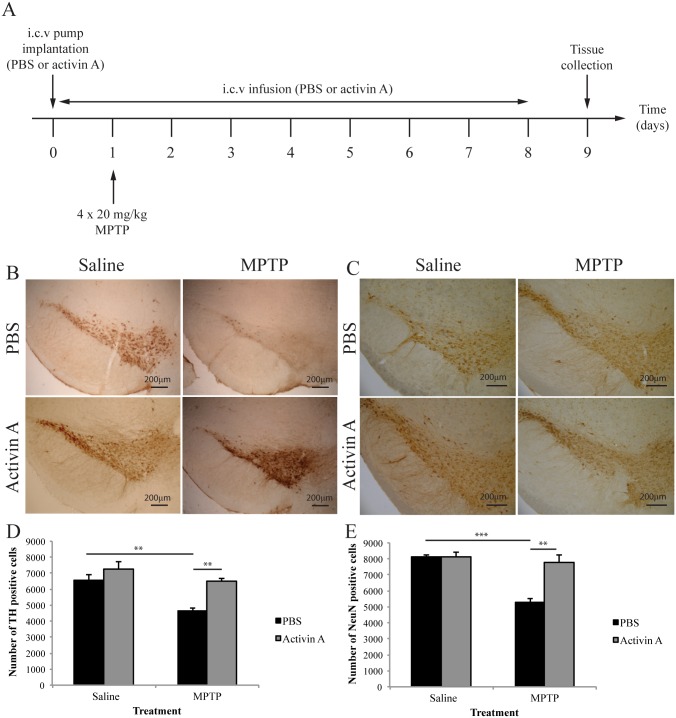
Activin A protects nigral neurons against MPTP-induced cell death.(A) Experimental timeline. (B) Representative images of TH-immunoreactive neurons in the substantia nigra pars compacta (SNpc). (C) Representative images of NeuN-immunoreactive neurons in the SNpc. (D) Stereological quantification of TH-immunoreactive neurons in SNpc demonstrates activin A protects dopaminergic neurons against MPTP toxicity. (E) Stereological quantification of NeuN-immunoreactive neurons in the SNpc demonstrates activin A protects total neuron numbers against MPTP induced toxicity. All values represent the mean ± SEM. *p<0.05, **p<0.01, ***p<0.001. Scale bar represents 200μm. N = 5/group.